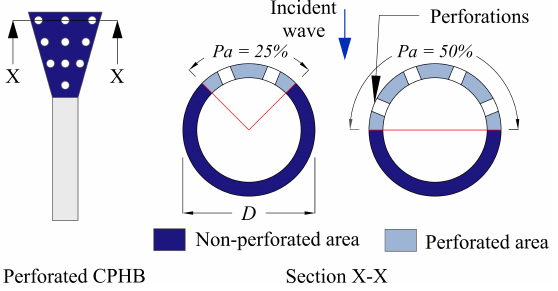
Figure 3. Typical computation of distribution of perforations ( Pa